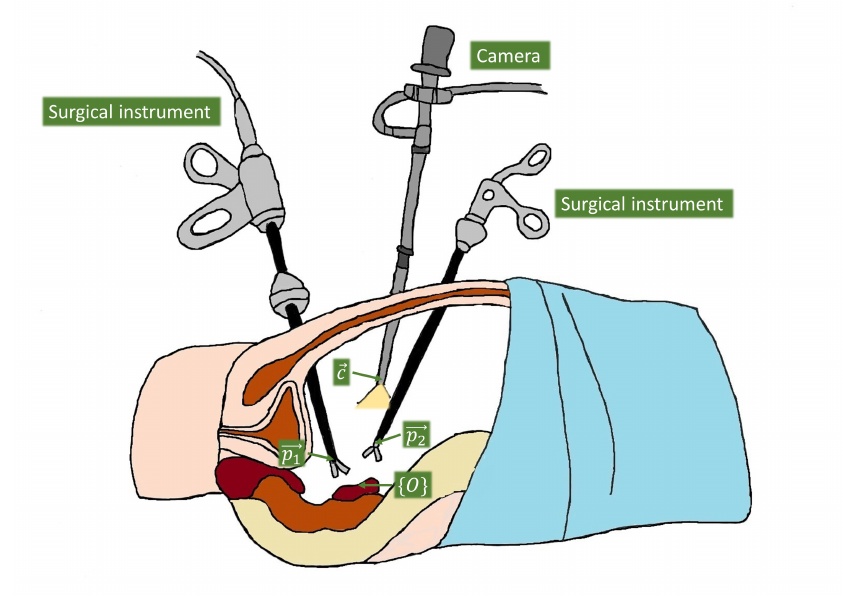
Figure 1. General scenario of an abdominal laparoscopic